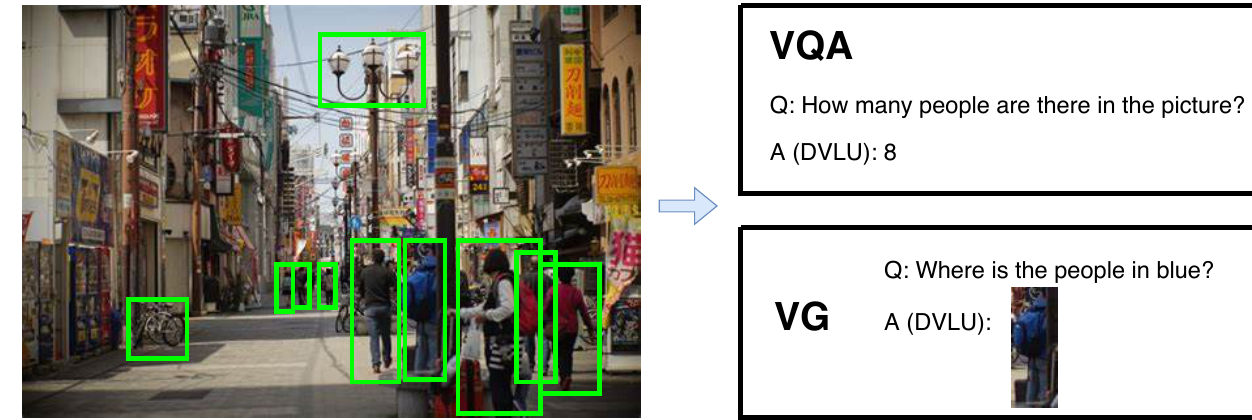
Figure 1. A DVLU system in a smart city. Specifically, VQA needs to answer with natural language while VG needs to answer with a grounded